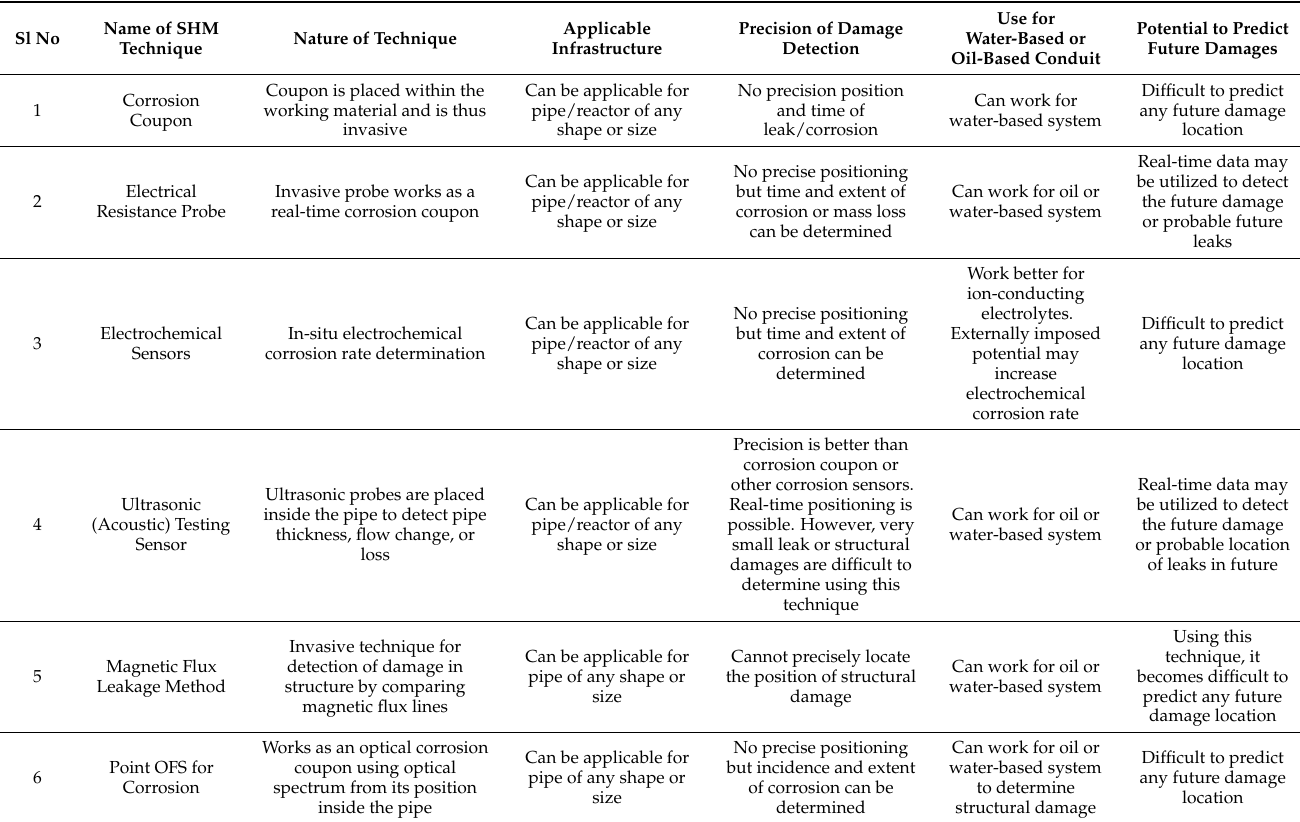
Figure 12. Metallic thin film-coated optical fiber sensors (OFS) for distributed corrosion sensing interrogated using Optical Frequency-Domain Reflectometry (OFDR) [71]: ( a ) Rayleigh backscattered light increases as the corrosion of Fe proceeds due to light absorption of metallic film; ( b ) Microstrain on the fiber increases with mass loss of coated Ni film due to release of compressive internal stress induced by Ni deposition. Note: (1)—single-mode fiber core; (2)—cladding; (3)—polymer jacket; (4)—coated metallic film; (5)—multi-mode fiber core. Table 2. Techniques of SHM and their descriptions.